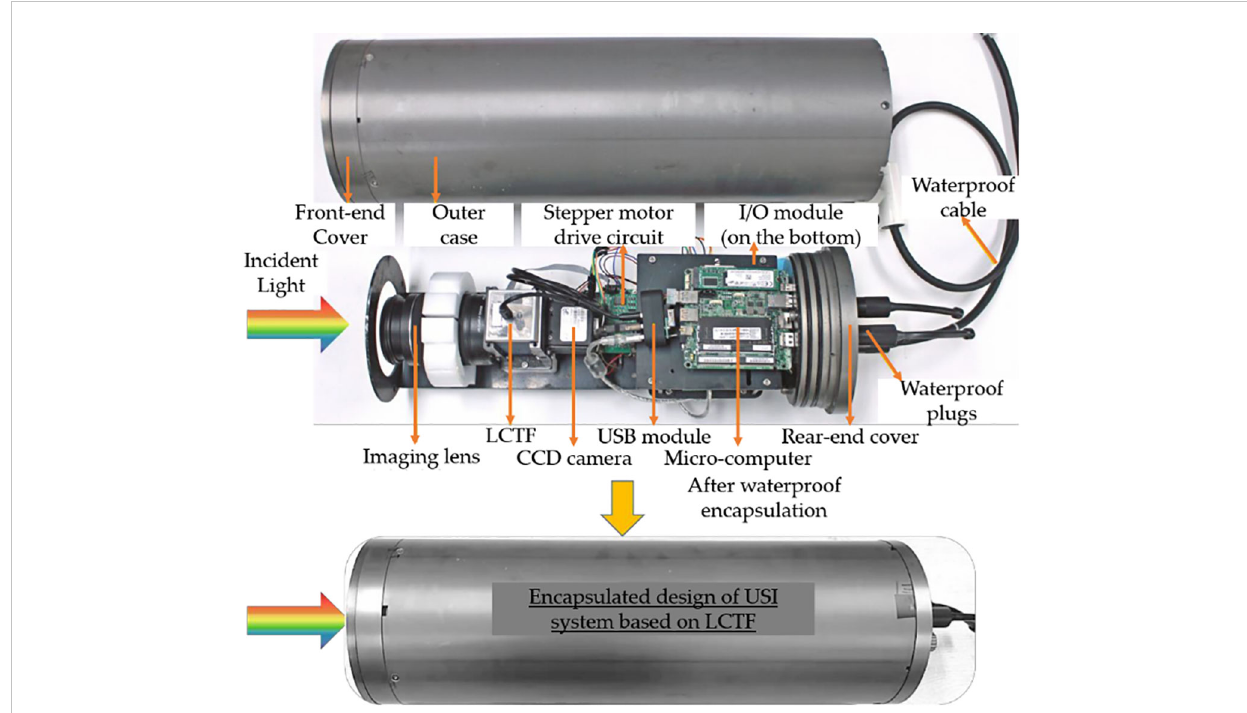
FIGURE 1 Encapsulated structure of the designed USI system. The hardware includes optical (lens, LCTF, and imaging sensor) and control (microcomputer, motor drive circuit, remote I/O circuitry, and voltage converter) modules installed in a waterproof mechanical structure (Song et al.